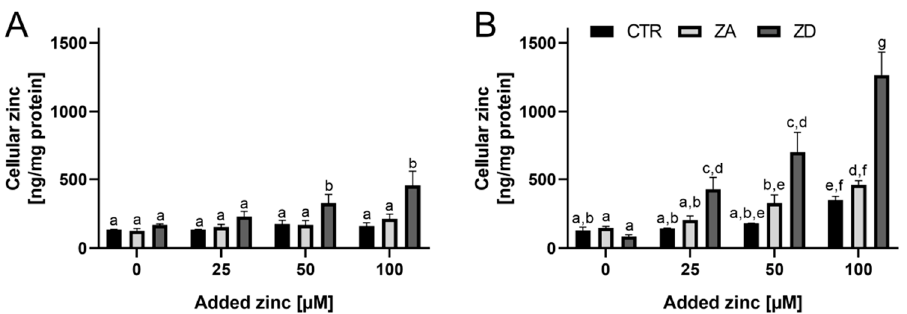
Figure 3. Zinc uptake of HT-29-MTX during zinc deficiency. HT-29-MTX cells were cultured for 7 days ( A ) and 14 days ( B ) in CTR, zinc-adequate (ZA) or -deficient (ZD) medium. Cellular zinc after treatment with 0–100 µM zinc for 24 h was quantified with inductively coupled mass spectrometry (ICP–MS) and is presented relative to protein content of the cells. Data are shown as means + SD of three independent experiments. Bars sharing letters are not significantly different (Two-Way ANOVA with Bonferroni post-hoc test).